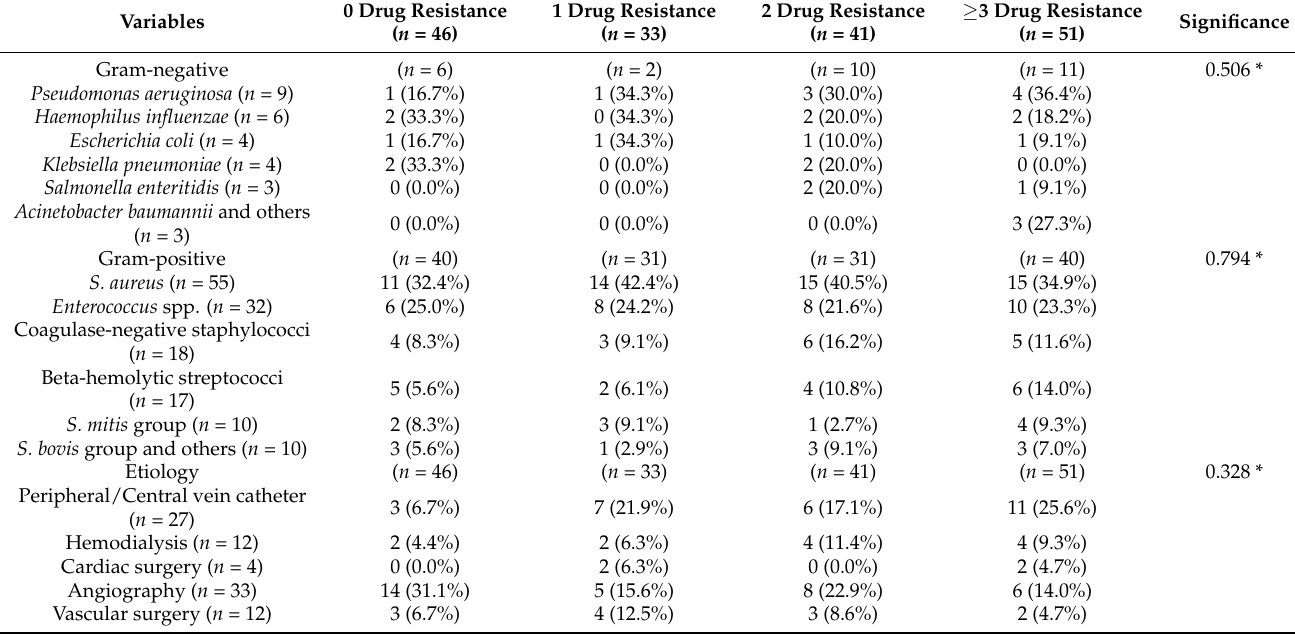
Table 5. Antimicrobial resistance pattern by etiology of infection.